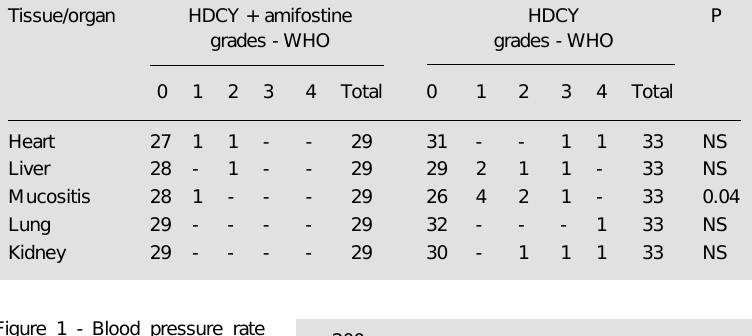
(min)Figure 1 - Blood pressure rate following amifostine